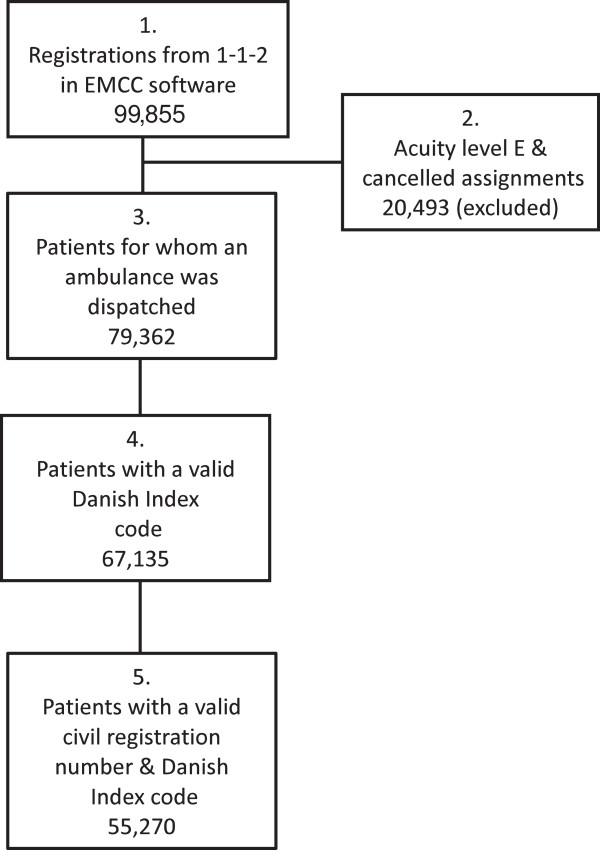
Included patients and patients lost to follow-up due to incomplete registration. Box 1: Total number of 1-1-2 registrations in the study period. Box 2: Excluded patients. Emergency level E and cancelled assignments. Box 3: All patients that received an ambulance via a 1-1-2 call. Box 4: Patients, that received an ambulance via a 1-1-2 call, with a valid Danish Index code registered. Box 5. Patients that received an ambulance via a 1-1-2 call, with a valid Danish Index code and a valid civil registration number registered (making complete follow-up possible).